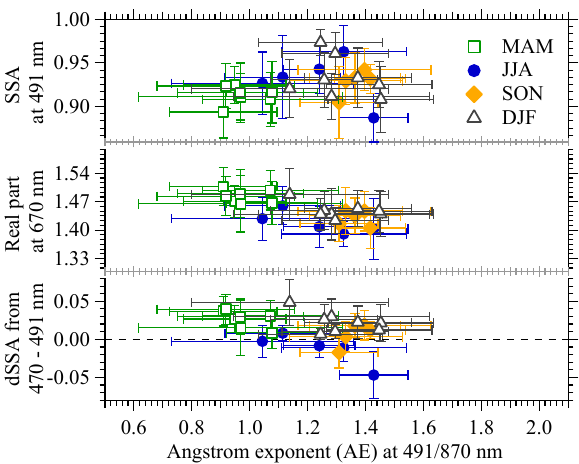
Figure 9. Relationships between the monthly mean values of 491nm SSA and total Ångström exponent (AE) at 491 / 870nm (a) , between the monthly mean values of the real refractive index at 670 and AE at 491 / 870nm (b) and between the monthly mean values of the SSA difference (870–491nm) and AE at 491 / 870nm (c)